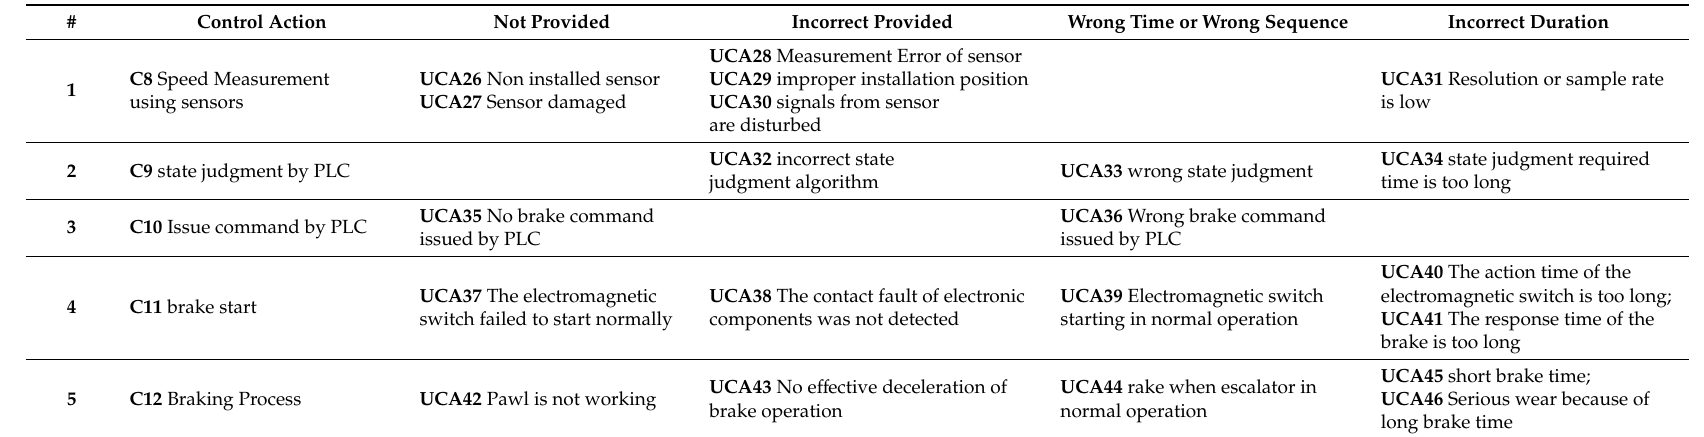
Table 6. Potentially hazardous control actions in Level